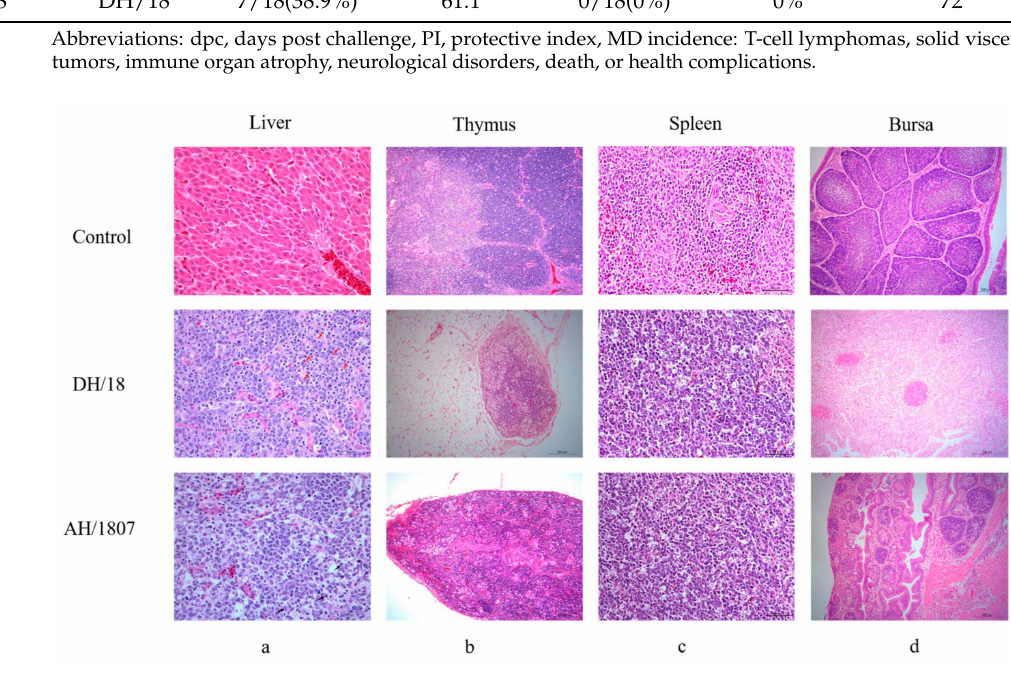
Figure 2. Hematoxylin and eosin-stained histological lesions of collected tissues. Control, AH/1807-, and DH/18-challenged groups were compared for each tissue. ( a ) Liver, DH/18 invasive growth of tumor cells, pyknosis of liver nuclei, and excessive necrosis. AH/1807, a large number of tumor cells infiltrating and proliferating, with frequent pathological mitotic phases. Liver cells are necrotic in large numbers, and normal tissues are rarely visible. Tumor cells are mainly lymphoblastic. Scale bar: 50 µ m. ( b ) Thymus, DH/18 atrophy, significant decrease in cortical lymphocytes, proliferation of macrophages, and proliferation of adipose tissue around the thymus. AH/1807 thymus atrophy, massive necrosis, and reduction in cortical lymphocytes, and proliferation of macrophages. Scale bar: 200 µ m. ( c ) Spleen, DH/18 local necrosis of the parenchyma with a large number of tumor cells infiltrating, and the tumor cells are mainly lymphoblastic. AH/1807, local necrosis of the parenchyma with a large number of tumor cells infiltrating, most of which are mitotic, and the tumor cells are mainly lymphoblastic. Scale bar: 50 µ m. ( d ) Bursa, DH/18 follicle atrophy, multiple necrosis, massive necrosis, reduction in lymphocytes, and mild interstitial hyperplasia. AH/1807 fold atrophy, significant necrosis of follicular lymphocytes, and interstitial hyperplasia. Scale bar: 200 µ